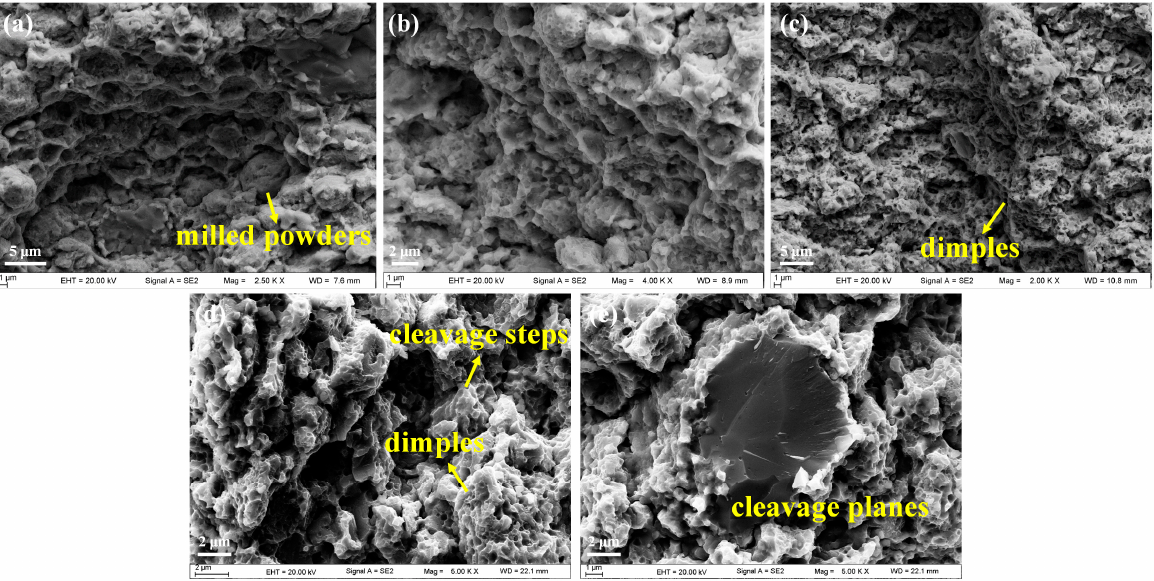
Figure 19. SEM images of the fracture morphology for specimens: ( a ) A1, ( b ) A2, ( c ) A3, ( d , e ) A4.